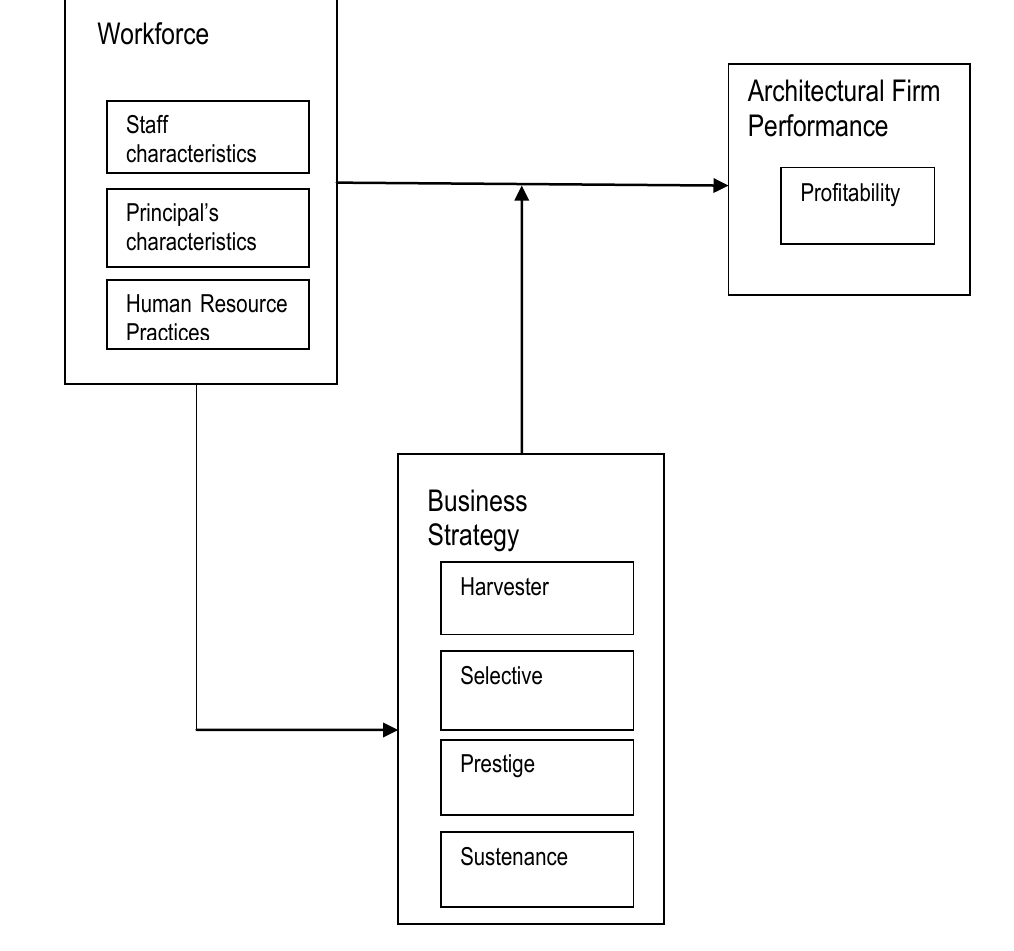
Figure 1 Workforce, business strategy and